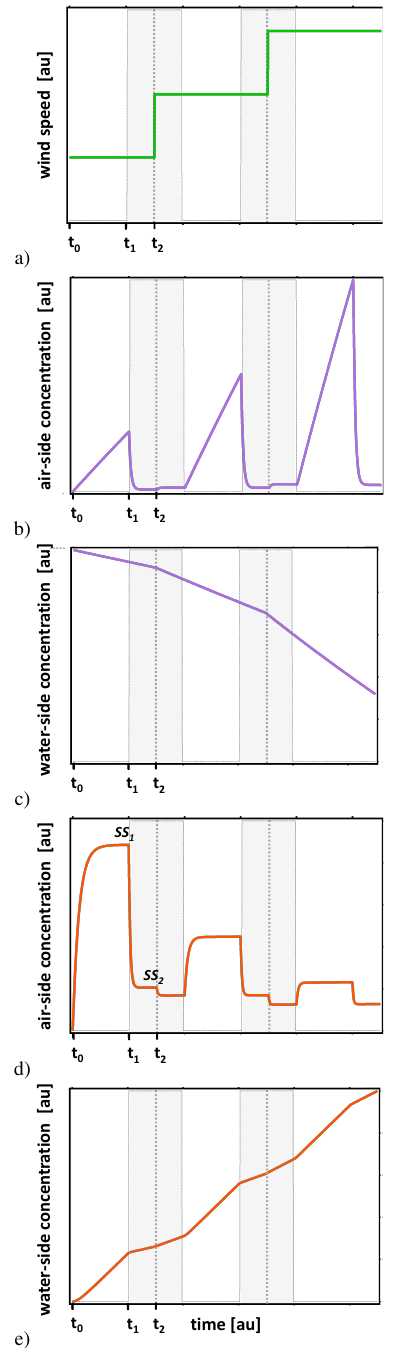
Figure 2. Simulated concentration time series for a water ( b and c ) and an air-side controlled ( d and e ) tracer in both air and wa- ter phase, at three example wind speed conditions. The grey back- ground denotes the air-phase flashing periods and the dashed lines the change of the wind speed condition. SS 1 and SS 2 mark the de- veloped steady